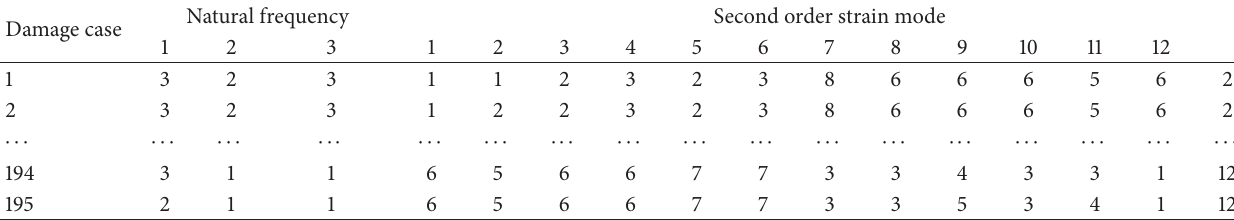
Table 8: Attribute set 2 rules generation for damage bay.